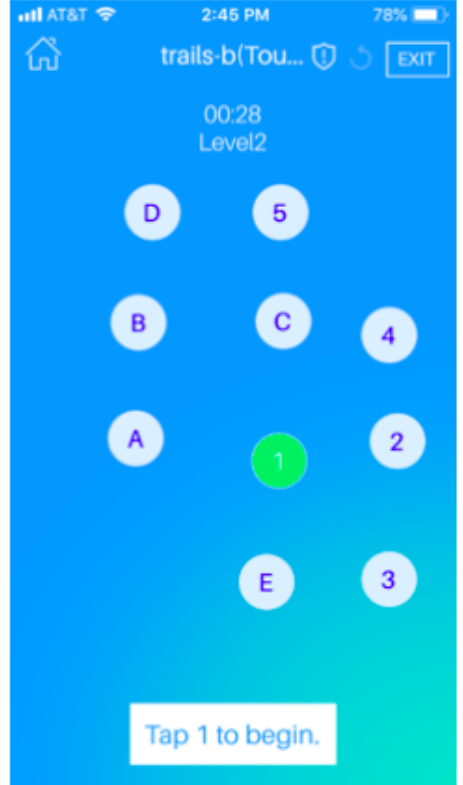
Figure 1. Digital equivalents of traditional neuropsychological tests. In the mindLAMP app, the traditional Trailmaking Test B is translated to the smartphone screen (left). The task measures the accuracy and speed of finger taps between alternating numbers and letters. Spatial Span as an analog task involves a physical board with cubes; on a smartphone, squares light up in a sequential order, followed by a blank grid where the participant taps the same sequence of squares previously